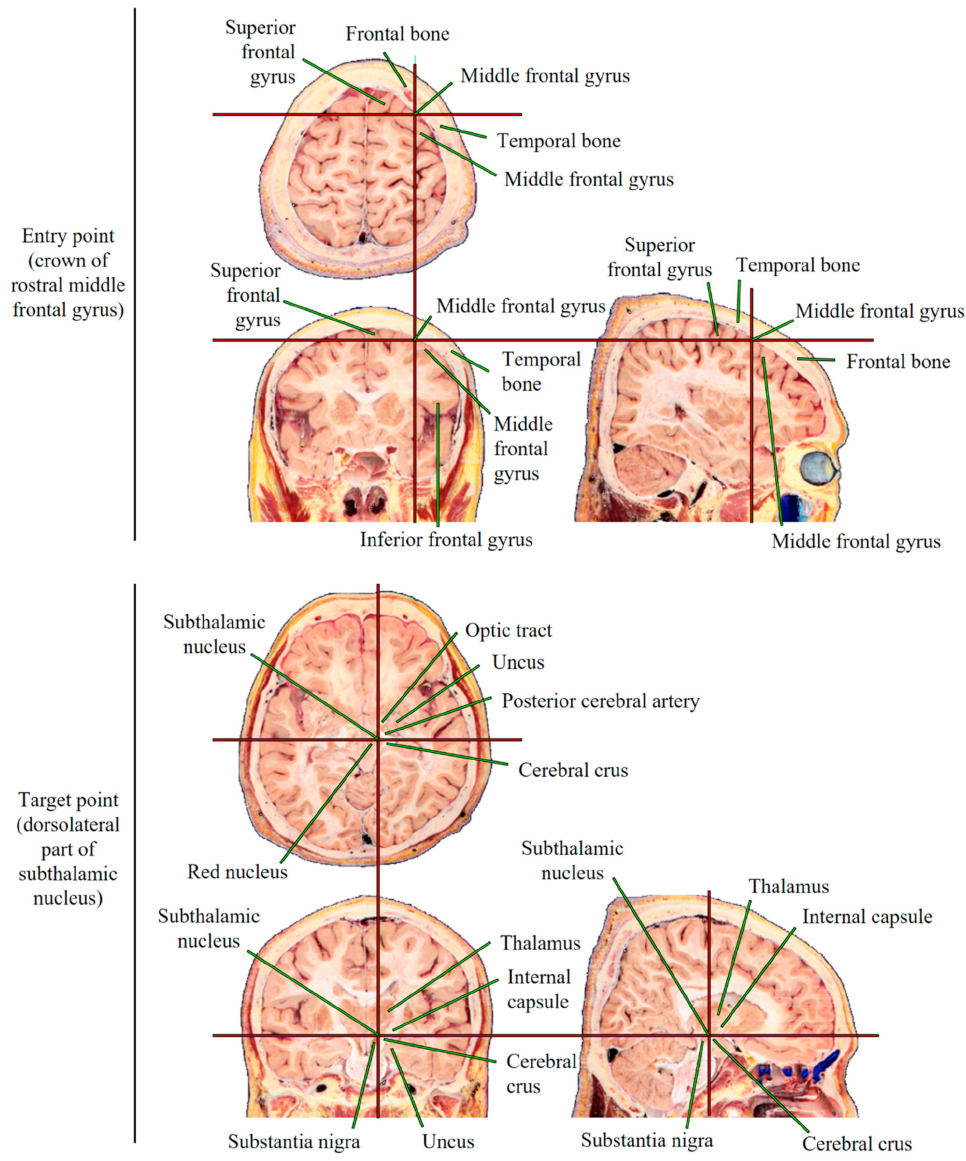
Figure 3. Horizontal, coronal, and sagittal planes on a real color volume model with the marked entry point and target point of the DBS